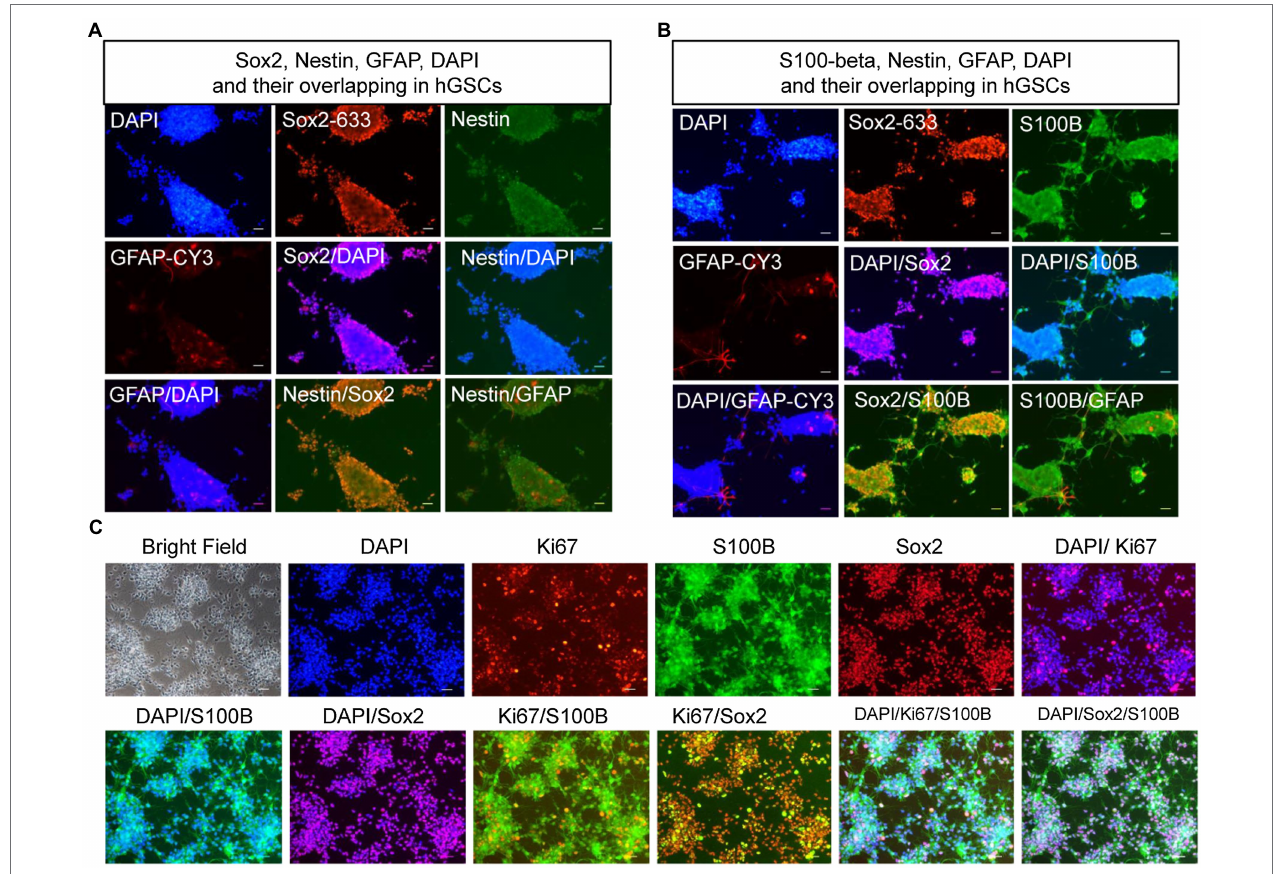
FIGURE 4 | Confirmation and characterization of hGSCs. (A–C) hGSCs were fixed and immunostained with GFAP, Sox2, and nestin (A) ; S100-beta, Sox2, and GFAP (B) ; and Ki67, S100-beta, and Sox2 (C) . Scale bar, 50 μ